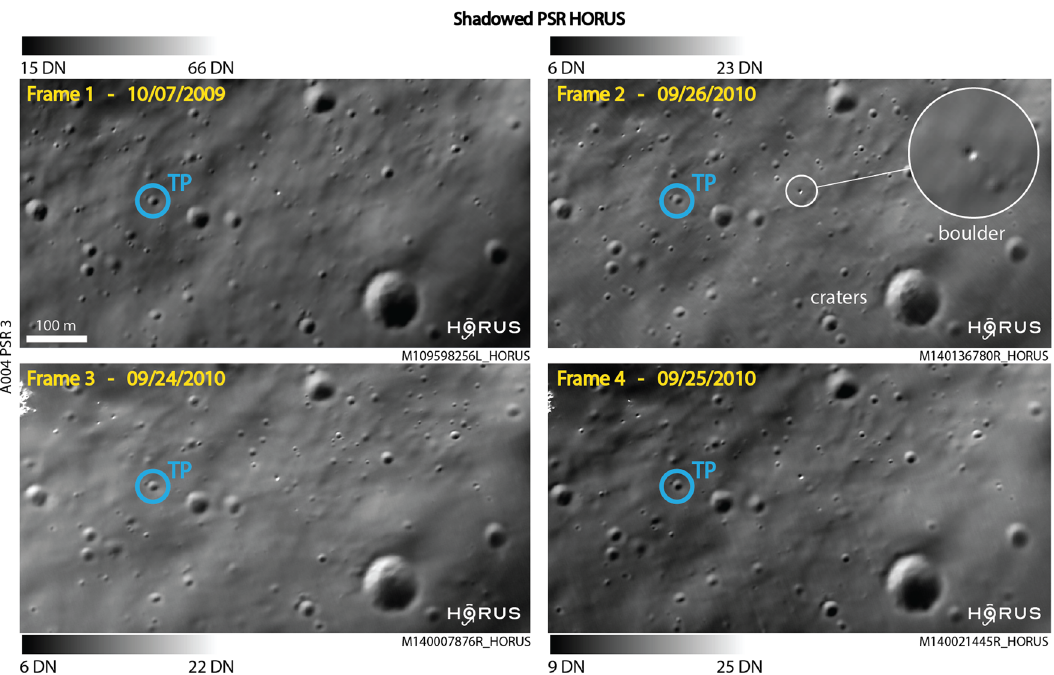
Fig. 4 Permanently shadowed regions validation of HORUS images. We compare multiple HORUS frames over the same PSR (permanently shadowed region). The vast majority of features appear consistent across all HORUS frames, i.e., they are shape-, dimension-, and location-consistent, and are thus considered to be physical (TP, true positives, blue). For this study, features are only considered physical if they appear in at least two HORUS images. In the examples above, the smallest resolved boulder diameter is ~4 m; the range of digital numbers (DN) is shown next to each panel. This fi gure also illustrates how HORUS can be used to study the temporal variability of PSRs on timescales of days and years, within the limitations of the method. Raw NAC (Narrow Angle Camera) image credits to